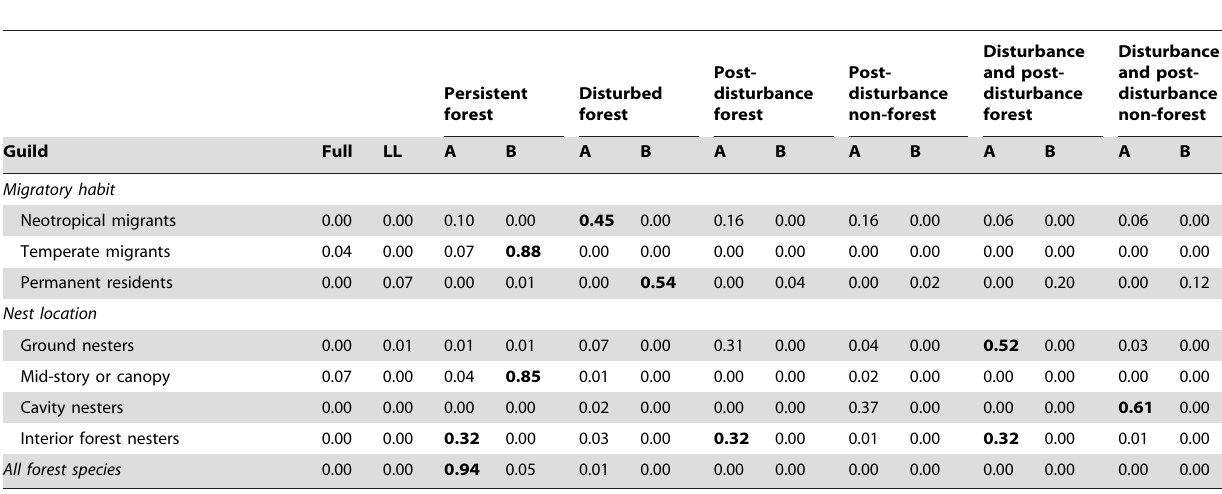
Table 2. Support (Akaike weights) for models of progressive similarity and forest disturbance, by guild, on Breeding Bird Survey routes located in forested ecoregions of the conterminous United States,